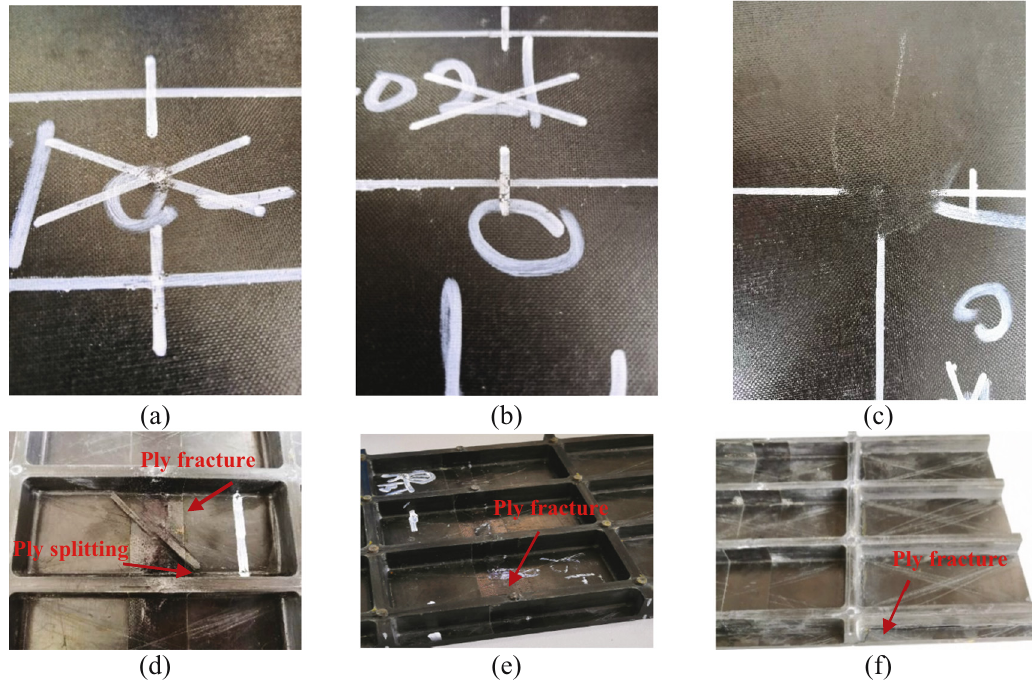
Figure 5: ( a and d ) External damage of #2 specimen; ( b and e ) external damage of #3 specimen; and ( c and f ) external damage of #4 specimen.